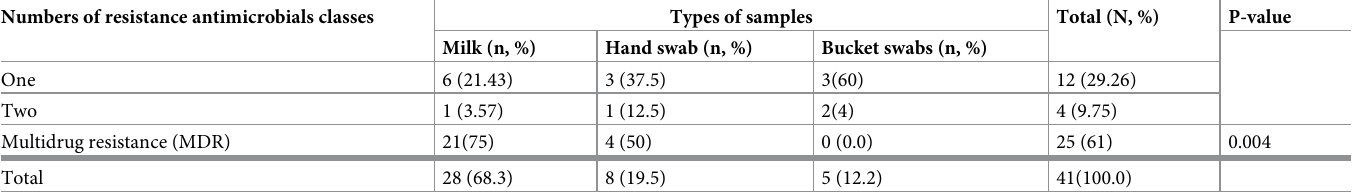
Table 4. Number and percentages of resistant S . aureus to antimicrobials in milk, dairy farm workers’ hand, and milking bucket swabs. Numbers of resistance antimicrobials classes Types of samples Total (N,